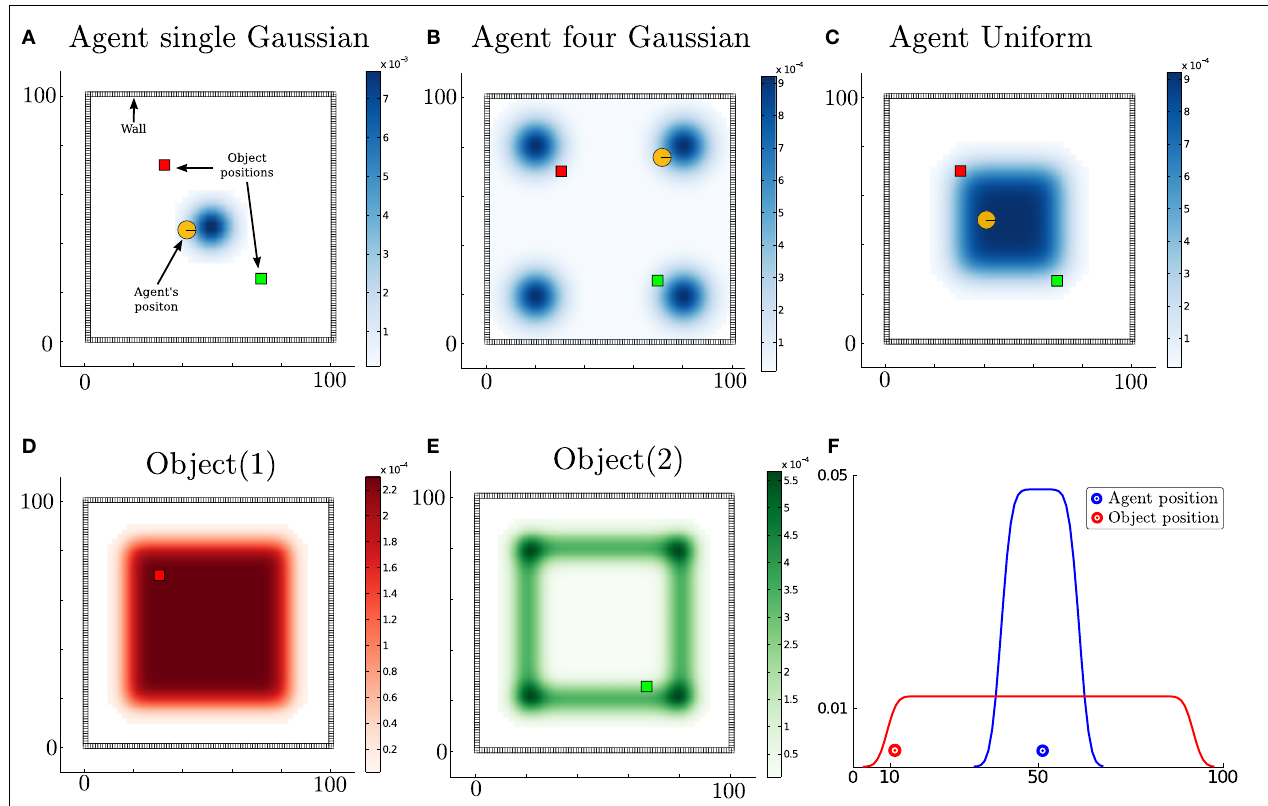
FIGURE 13 | Agent’s prior beliefs. Two types of environment, the first is a 2D world where the agent lives in a square surrounded by a wall while the second is a 1D world. In the 2D figures, the agent is illustrated by a circle with a bar to indicate its heading. The true location of the objects is represented by color coded squares. Top row , (A–C) three different initializations of the agent’s location. Bottom row , (D) the agent’s prior beliefs with respect to the location of the first object and (E) belief of the second object’s location. Bottom row , (F) 1D world with one object.